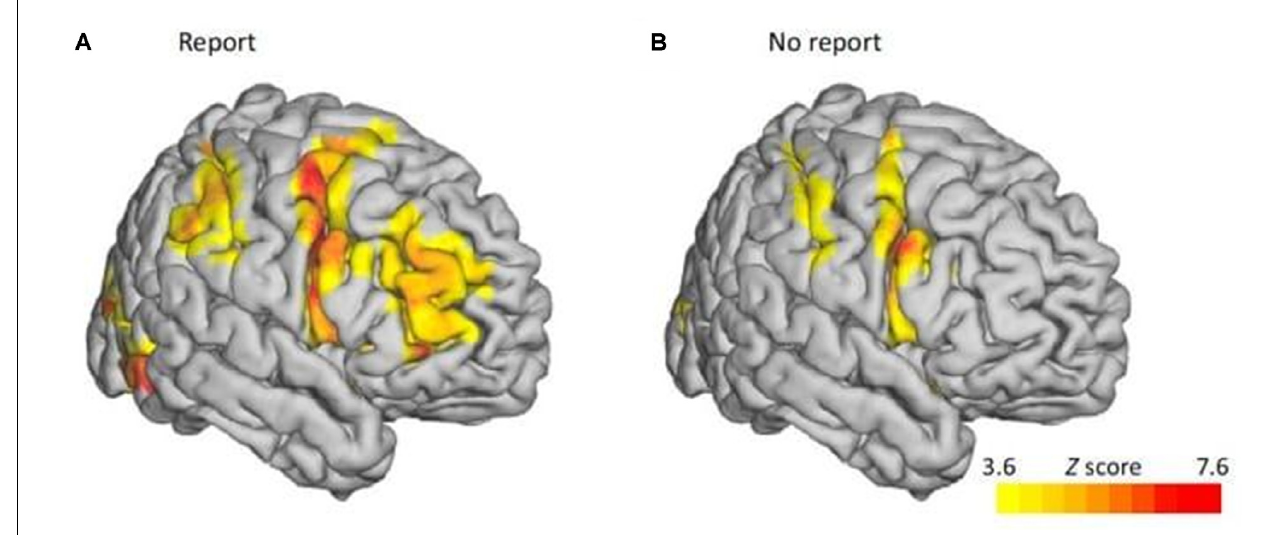
FIGURE 2 | fMRI results of Report vs. No-Report Binocular Rivalry. fMRI blood oxygen level-dependent (BOLD) contrasts between perceptual switches and yoked stimulus during binocular rivalry revealed lower activity in the prefrontal cortex in the report condition (A) compared to the no-report condition (B) . Adapted